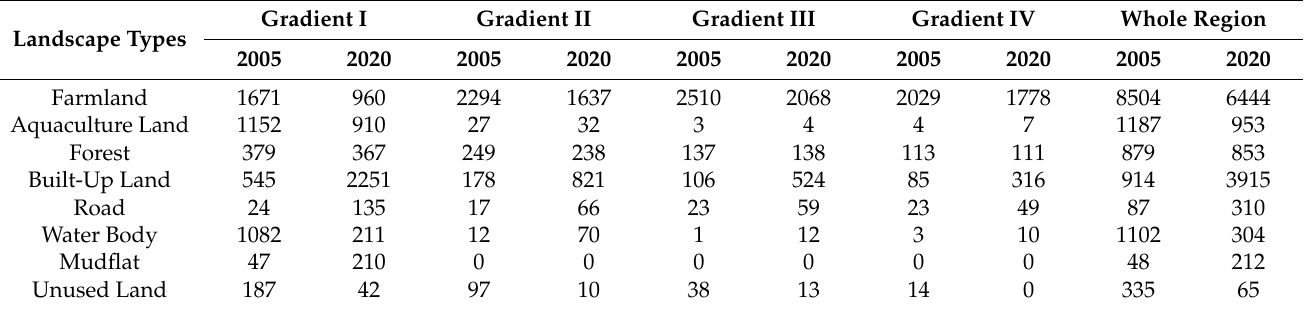
Table 12. Area of various landscape types in 2005 and 2020 (ha).